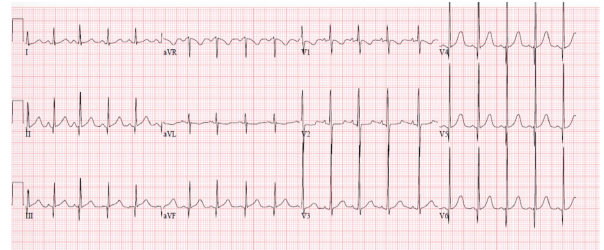
Figure 1: 12-lead electrocardiogram with increased R wave voltage above 98th percentile for age in leads V5 and V6 and Q wave in lead V6 above 98th percentile for age.